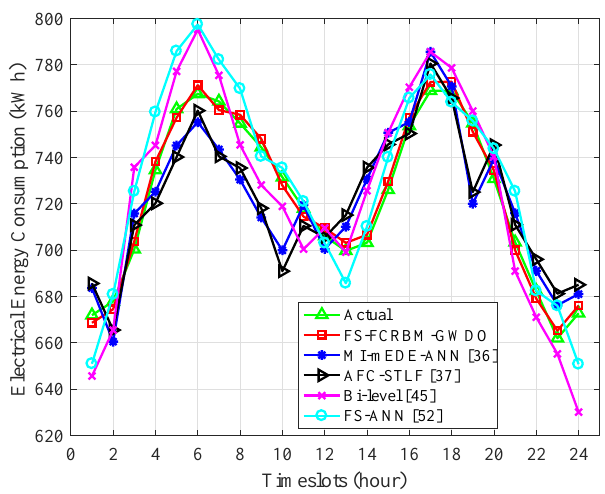
Figure 8. Day ahead electrical energy consumption forecasting on FE power grid data with hour resolution.